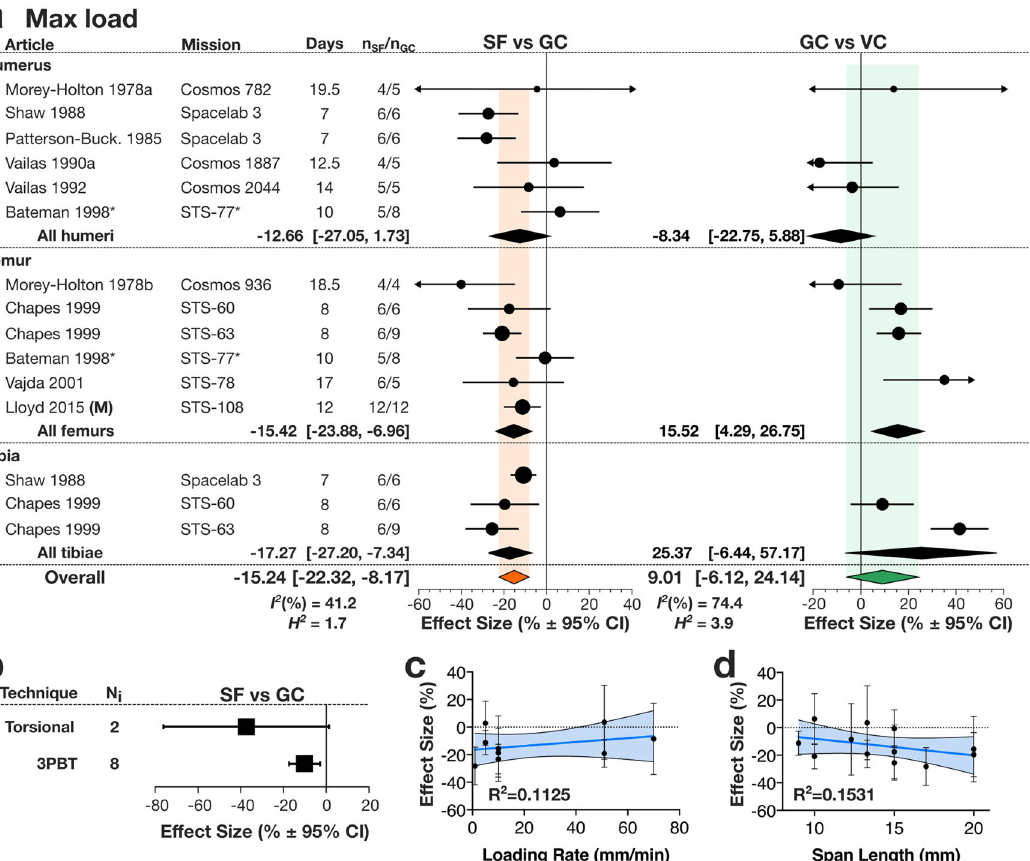
Fig. 2 Space fl ight-induced changes in max load of bone in rodent. a Forest plot of changes in max load in humerus, femur and tibia in space fl ight animals (SF) compared to ground control (GC) ( Left ); and GC compared to vivarium control animals (VC) ( Right ). Missions are ordered by mission year; mission name, duration (Days), SF and GC sample sizes (n SF /n GC ) are shown. Circle/line: effect size (%) and 95% CI, the size of the circle is proportional to the mission ’ s weight. Black diamonds : overall effect size and 95% CI for rats; color diamonds : overall effect size and 95% CI for rodents. I 2 and H 2 are for rodents. *indicates missions where there was no GC, and SF was compared to VC. b Subgroup analysis of measured max load by mechanical test: torsional test (Torsional) and 3-point bending tests (3PBT). Square/line: effect size (%) and 95% CI. N i : number of mission level outcomes. Meta-regression analysis of max load measures obtained by 3PBT as a function of loading rate ( c ) and span length ( d ) of the 3PBT machinery. Linear regression line ( dark blue ), its 95% CI ( light blue area ) and R 2 are